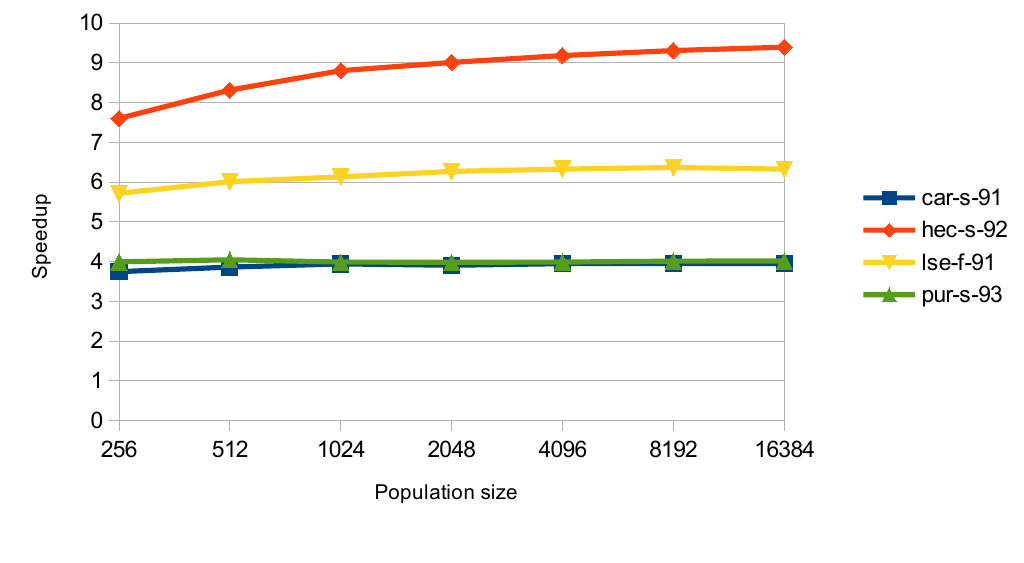
Figure 4. Speedup in the evaluation stage for the examination-threaded approach with the use of the compressed sparse row (CSR) conflict matrix.